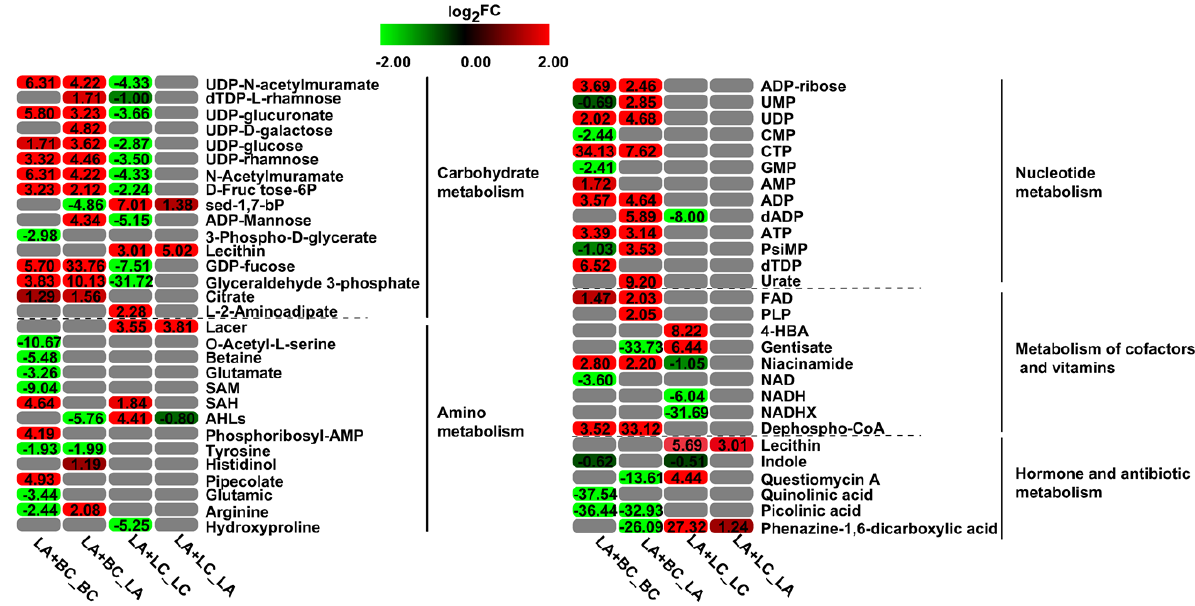
Figure 8. Quantification of differentially expressed metabolites involved in four primary metabolism and PGP-related pathways.